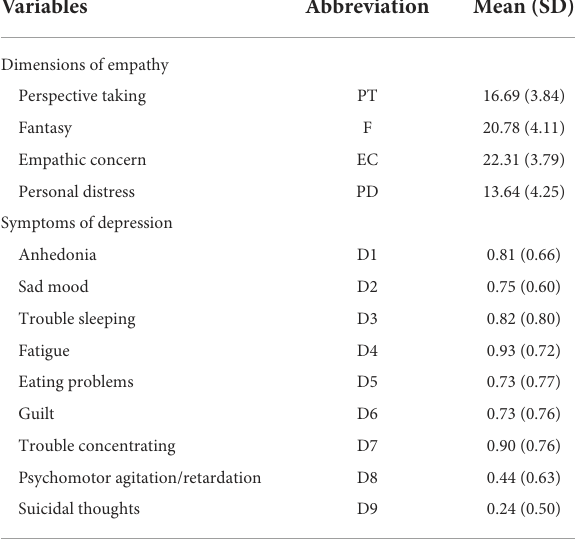
TABLE 2 Abbreviation, mean scores and standard deviations for each variable selected in the present empathy-depression